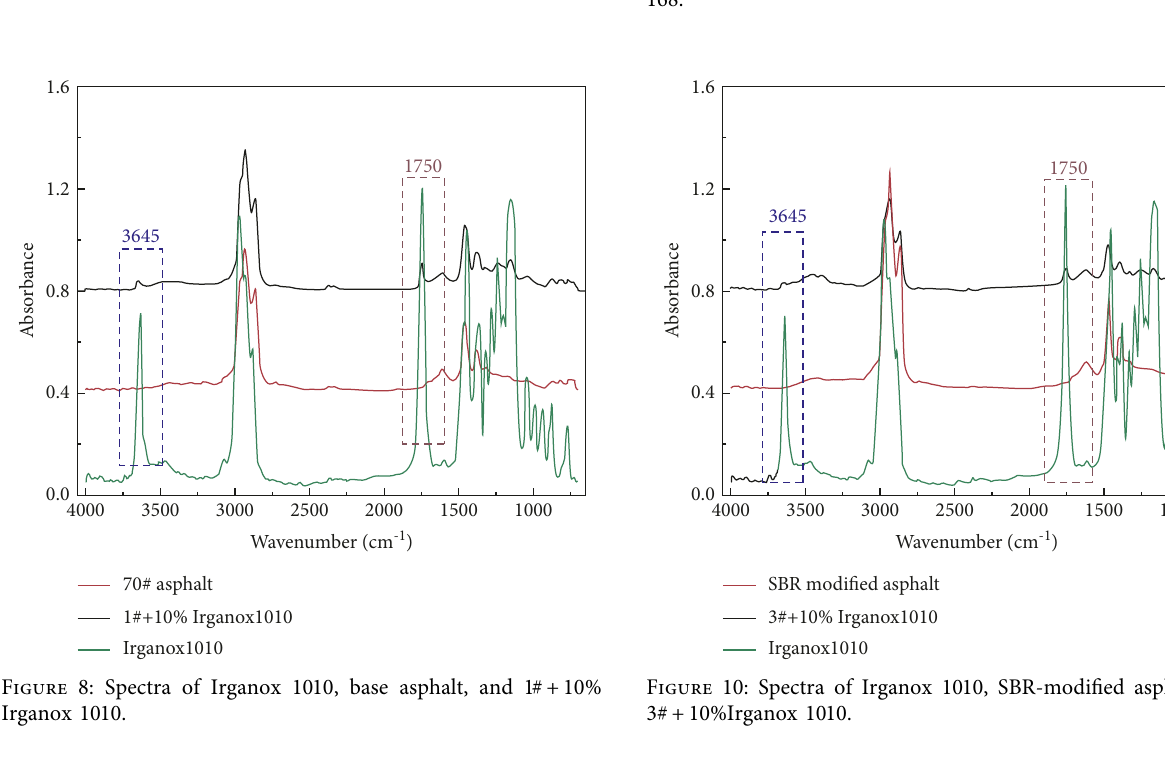
Figure 9: Spectra of Irgafos 168, 70# asphalt, and 2#+10%Irgafos 168.